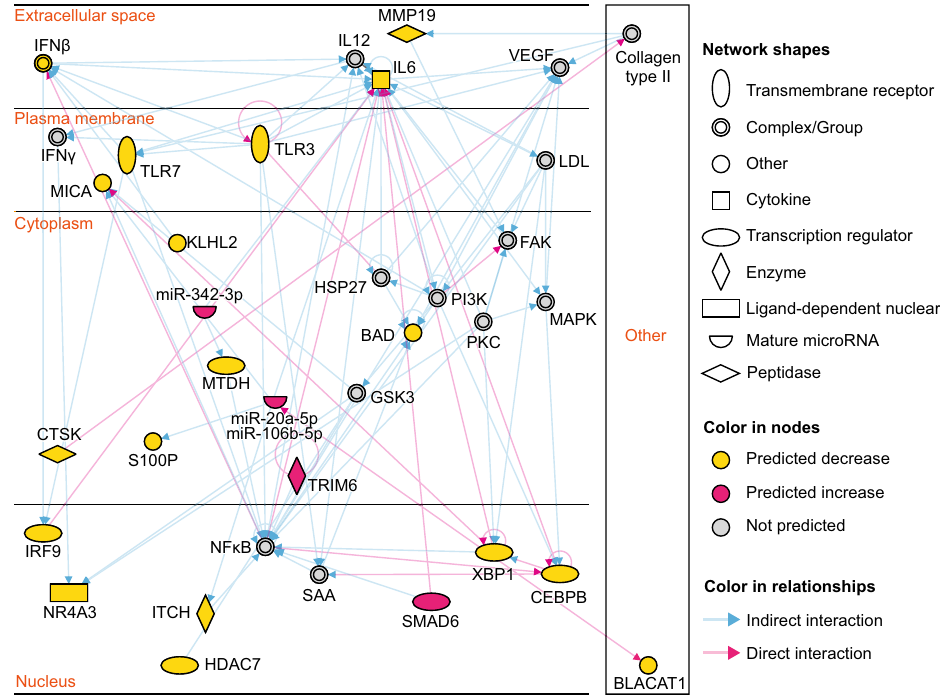
Figure 4. Target pathways related to immune response underlying SD. Immune regulation-related example of Ingenuity Pathway Analysis networks (score: 33) generated by analyzing DEMs and their target mRNAs (transcripts in Supplementary Table